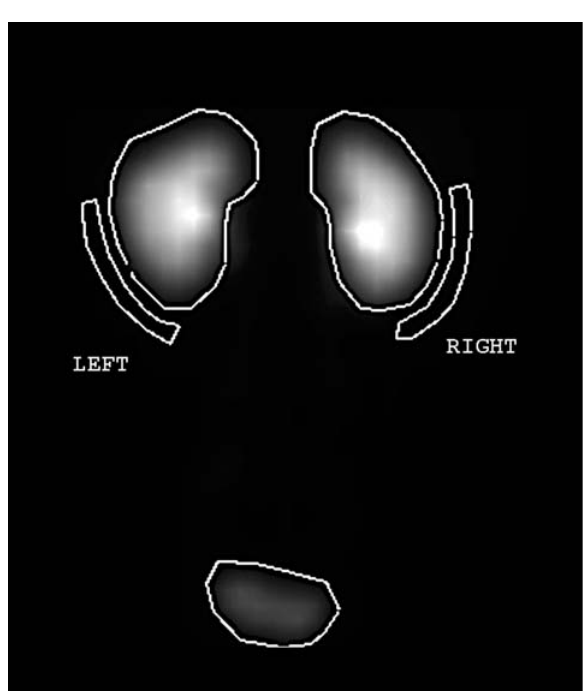
Figure 1 – Regions of interest (ROIs) drew manually in a com- posite image (1 to 3 minutes after the injection) of the 99m Tc-DTPA or 99m Tc-EC dynamic scintigraphies.